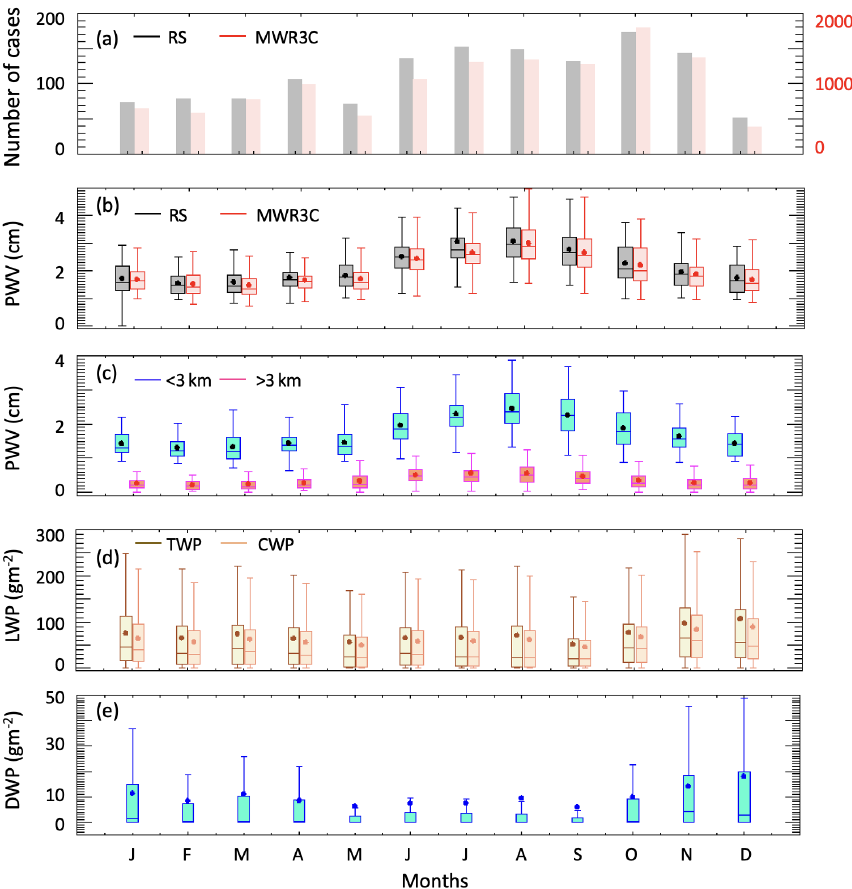
Figure 2. (a) Number of cases. (b) Annual cycle of total PWV from radiosondes (RSs) in grey and from the microwave radiometer in red. (c) Monthly mean of PWV below 3km in cyan and above 3km in pink from radiosondes. (d) Monthly mean total (dark brown) and cloud (light brown) water path derived from the MWR3C. (e) Monthly mean drizzle water path derived from the MWR3C. The dots denote the means, the boxes enclose the interquartile range (IQR), and whiskers extend to 1.5 times the